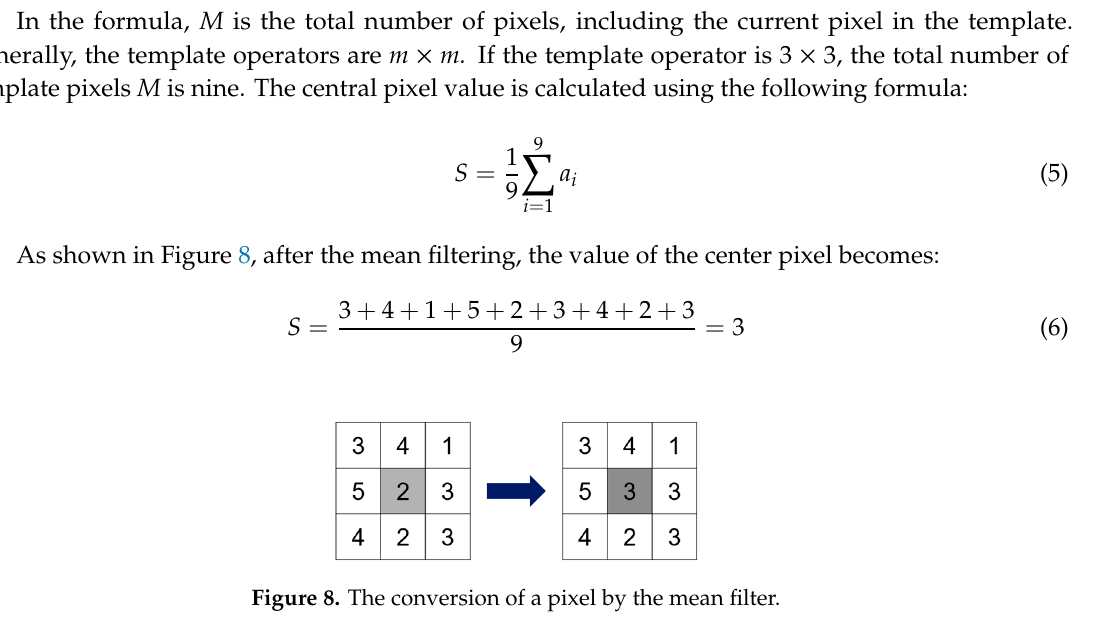
Figure 8. The conversion of a pixel by the mean filter.